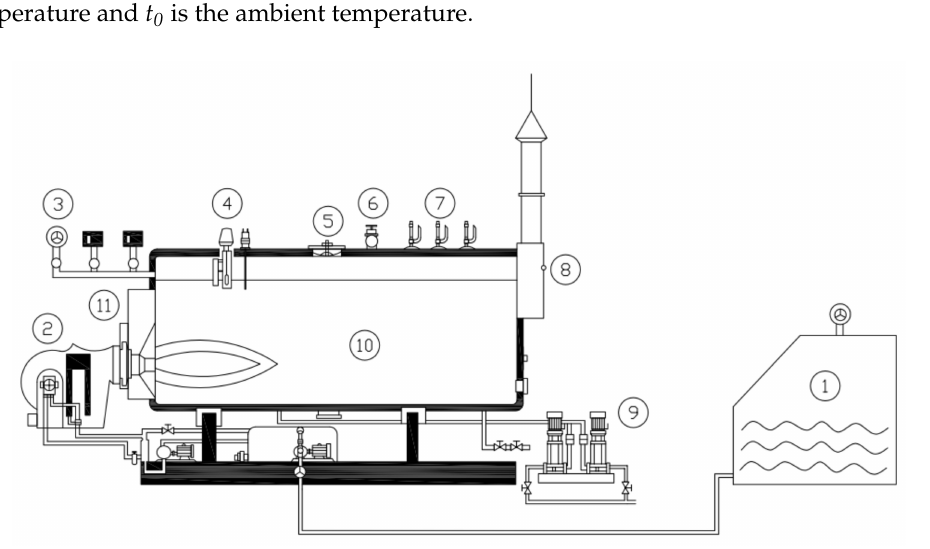
Figure 3. Experimental apparatus: 1: heating tank, 2: blower, 3: pressure gauge, 4: level